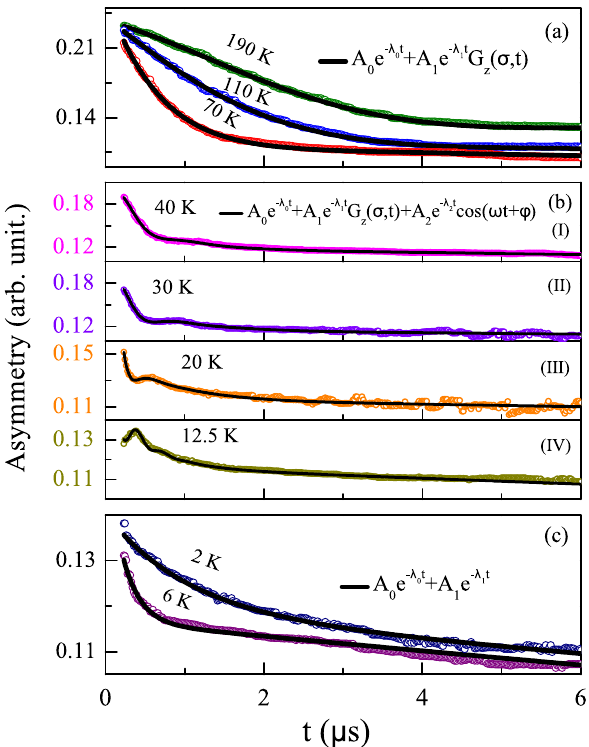
Figure 12. Zero-field µ SR spectra (a) at temperatures that can be fitted using Eq. (7), (b) at temperatures that can be well described using Eq. (9) and (c) at temperatures where the fitting equation (Eq. (7)) must have σ = 0